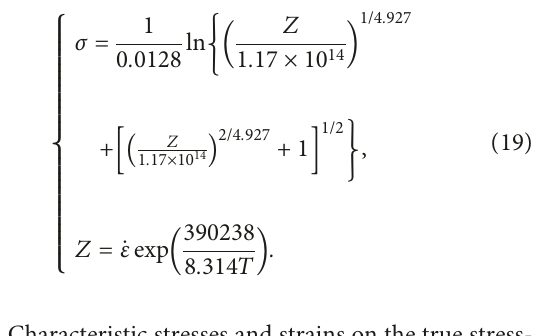
and _ ε m 3 exp ( Q DRX